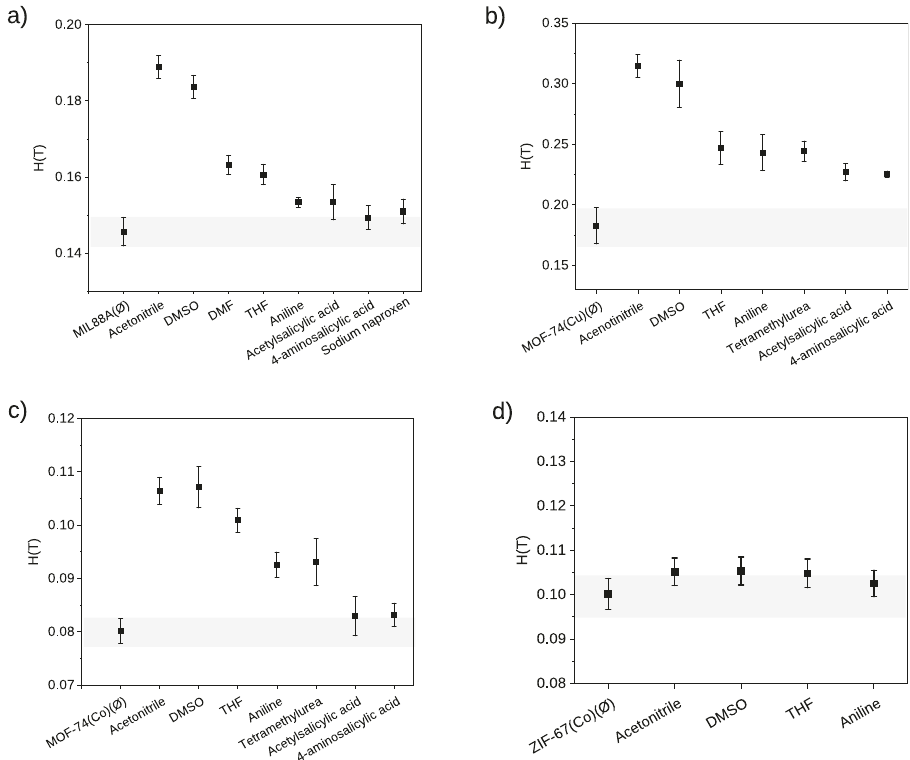
Fig. 6 Critical magnetic fi eld determined by magnetic sustentation experiments. Determination of the critical magnetic fi eld for: a MIL-88A(Fe), b MOF- 74(Cu), c MOF-74(Co) and d ZIF-67(Co) after being submerged 24 h and stirred in an aqueous (MIL-88A(Fe)) or ethanol (MOF-74(Cu), MOF-74(Co) and ZIF-67(Co)) solutions containing the adsorbate molecules. Samples labelled with Ø correspond to MOF samples not being exposed to any adsorbate. Each measurement was repeated fi ve times in order to provide the corresponding associated statistical error.